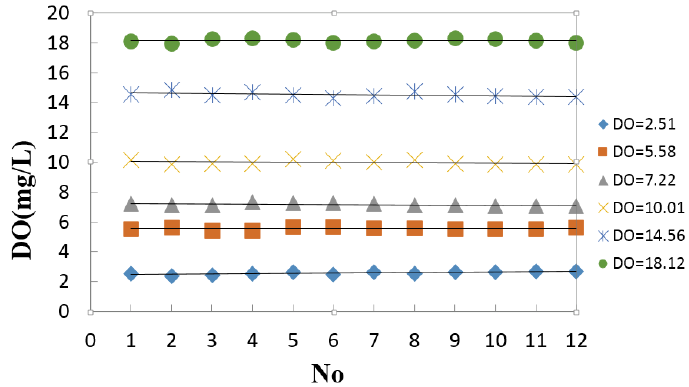
Figure 9. Stability test.